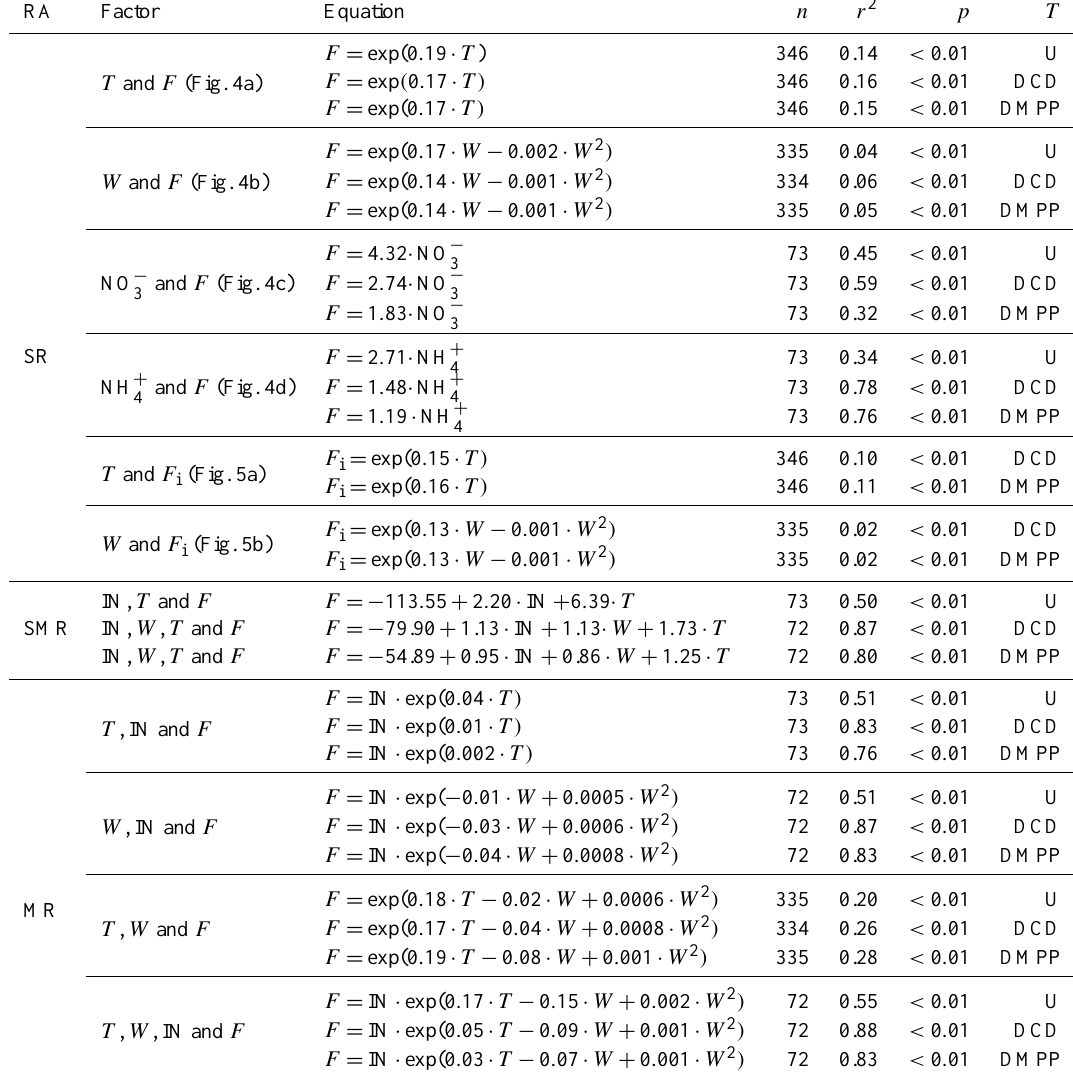
+ NH + , mgNkg − 1 SDW), and daily averaged N 2 O flux ( F , µgNm − 2 h − 1 ) or inhibited N 2 O flux ( F i 3 4